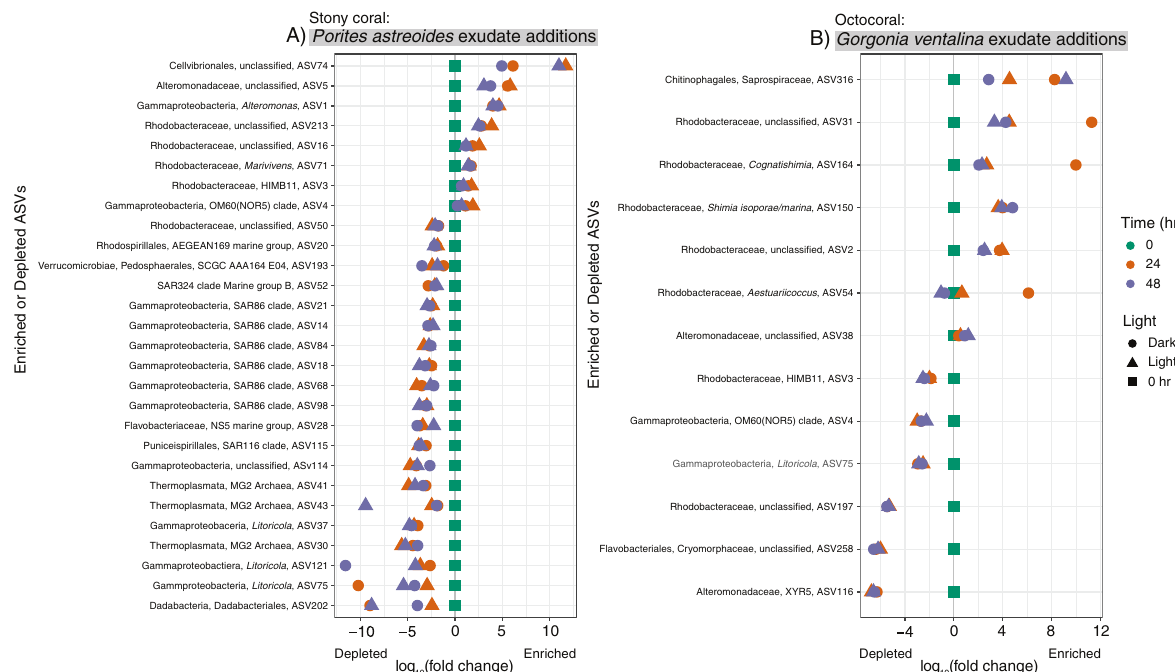
Fig. 4 Relative abundances of speci fi c microbial taxa increase or decrease in the presence of Porites astreoides and Gorgonia ventalina exudates. Log 10 (fold change) plots of averaged microbial 16 S rRNA gene ASV relative abundances (normalized to the initial time point at 0 h) that signi fi cantly and consistently increased or decreased in the presence or absence of Porites astreoides ( A ) and Gorgonia ventalina ( B ) exudates determined using corncob analysis. Only ASVs with coef fi cients of variation less than – 2 (depleted in coral exudate additions) and greater than 0 (enriched in coral exudate additions) were included to focus on ASVs displaying the most distinct changes. Symbol color re fl ects the time that samples were collected during the incubations and shape re fl ects light depressed Prochlorococcus cell abundances in the presence of light, indicating that Prochlorococcus may be sensitive to the interactive effects of light and speci fi c metabolite mixtures, although the mechanisms behind this response are unknown. G. ventalina exudates exhibited a rapid stimulatory response in Prochlorococcus in both the dark and light treatments within 24 h, suggesting that G. ventalina metabolites hasten cell division in Prochlorococcus more so than just the presence of light alone. Exudates from P. astreoides consistently enriched for speci fi c ASVs identi fi ed as unclassi fi ed Rhodobacteraceae, gammaproteo- bacteria within the OM60(NOR5) clade, other unclassi fi ed gam-